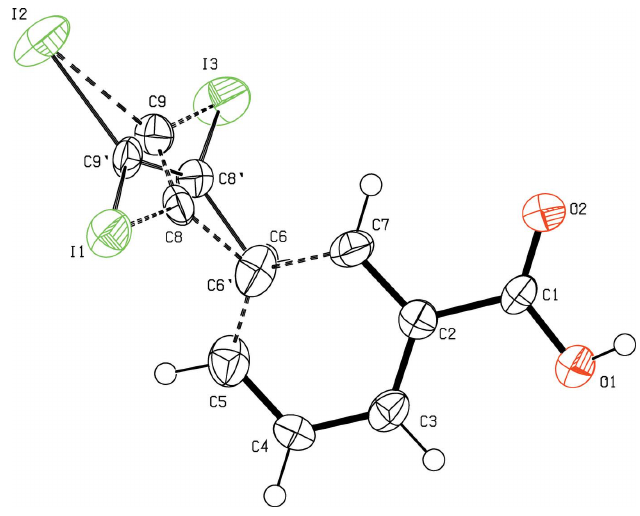
Figure 1 The molecular structure of 3-(1,2,2-triiodoethenyl)benzoic acid, with displacement ellipsoids drawn at the 50% probability level.